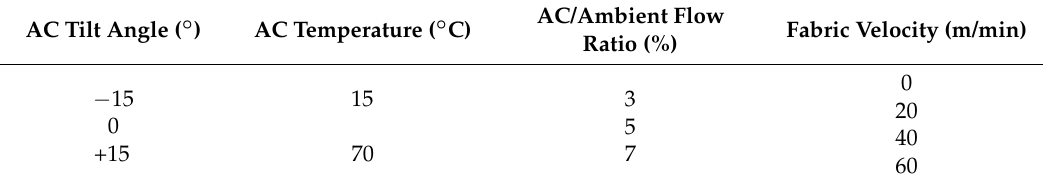
Table 1. Parameters determining stenter model configurations investigated with CFD.